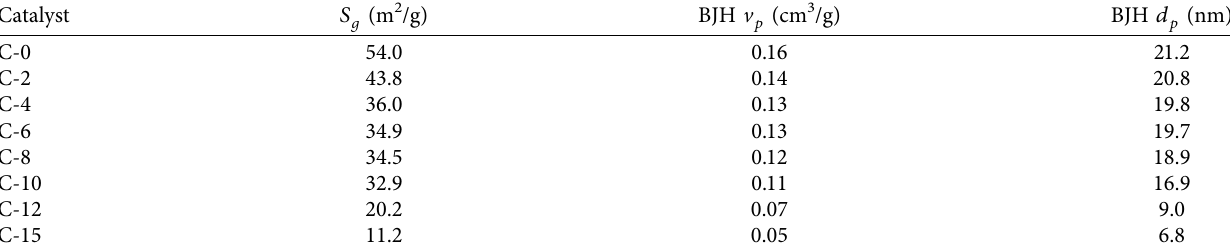
Table 1: Textural properties of the